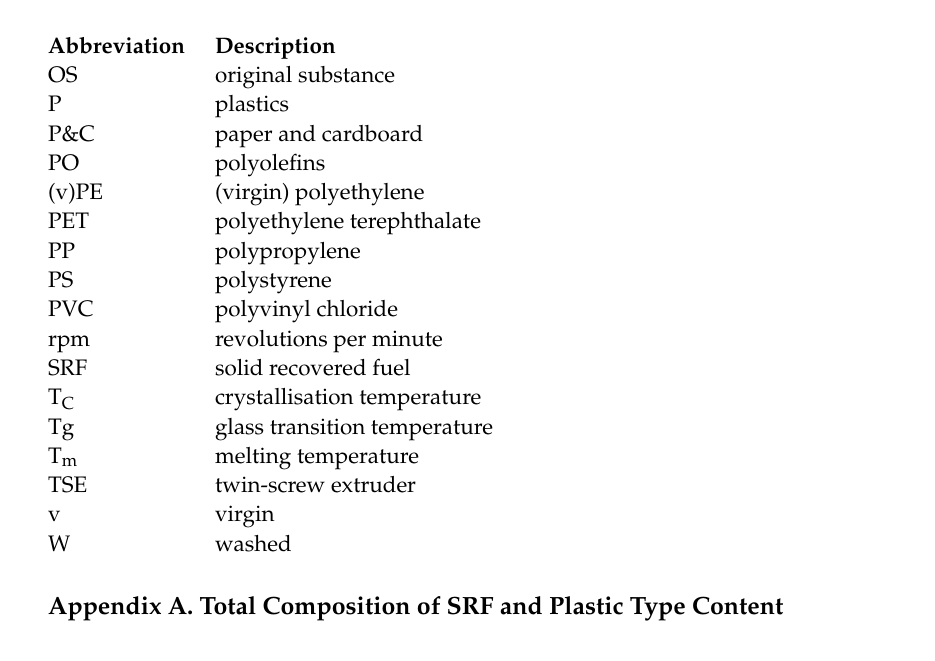
Table A1. Total composition of SRF determined by manual sorting analysis (Note: fine fraction <20 (8.5%) mm was separated and is not considered in the table).